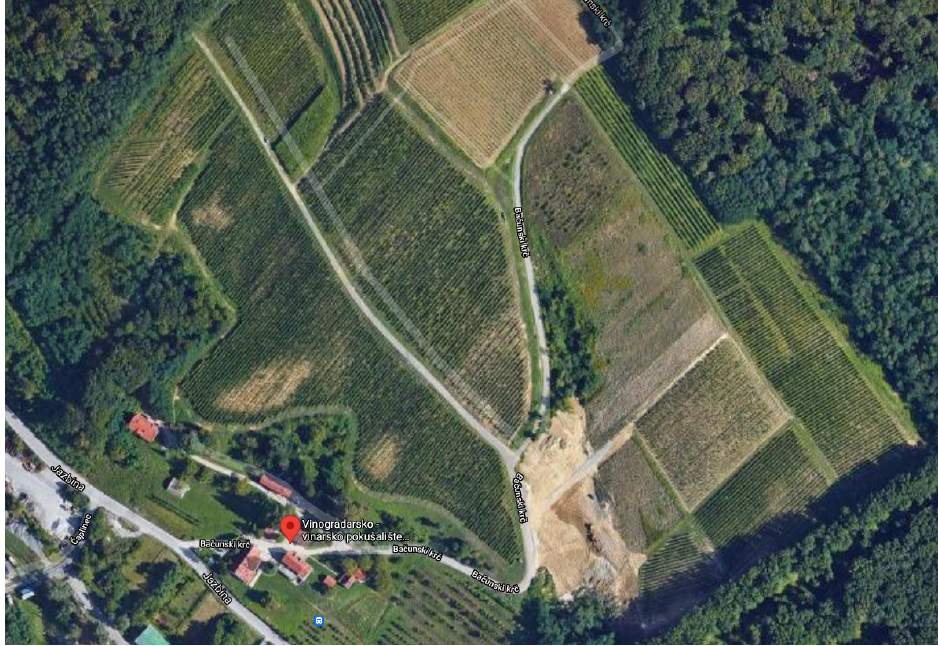
Figure 3. Layout of the Jazbina vineyard, Faculty of Agriculture, University of